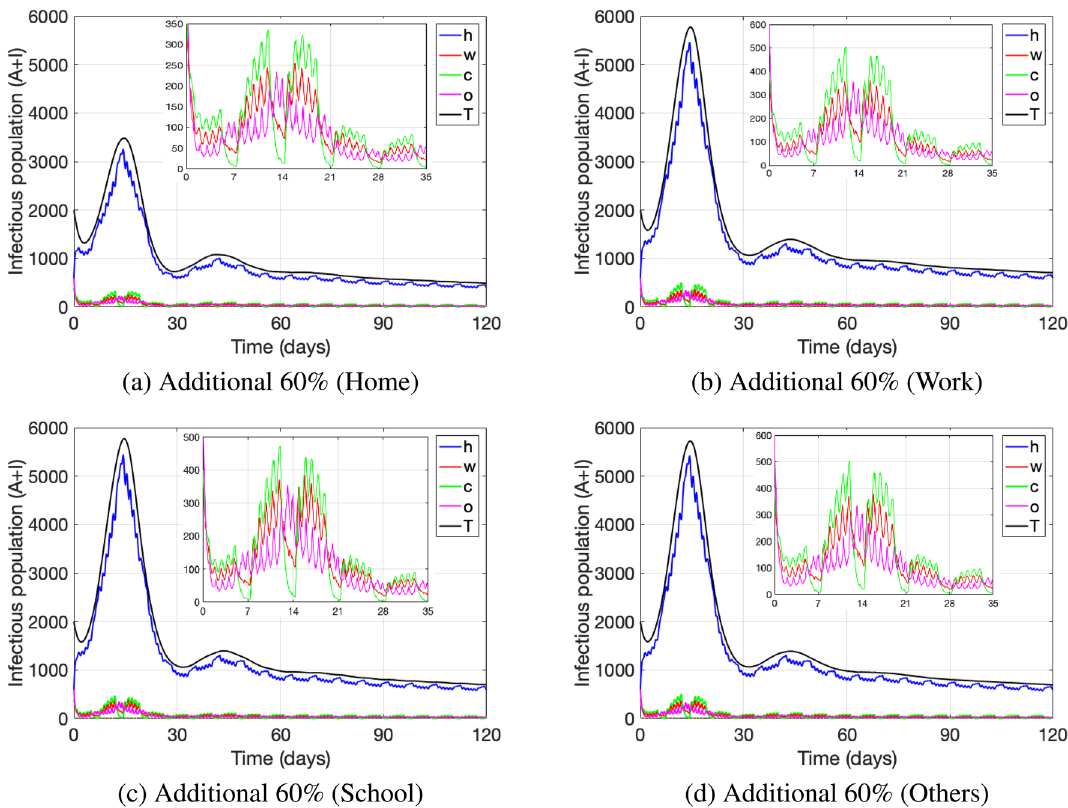
Figure 9. Addition (in percentage) to the transition rate leading to quarantine upon a close contact at a specific location. The parameter values used are as in Table